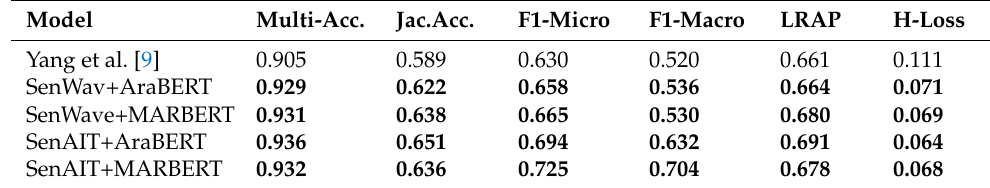
Table 5. Comparison with published